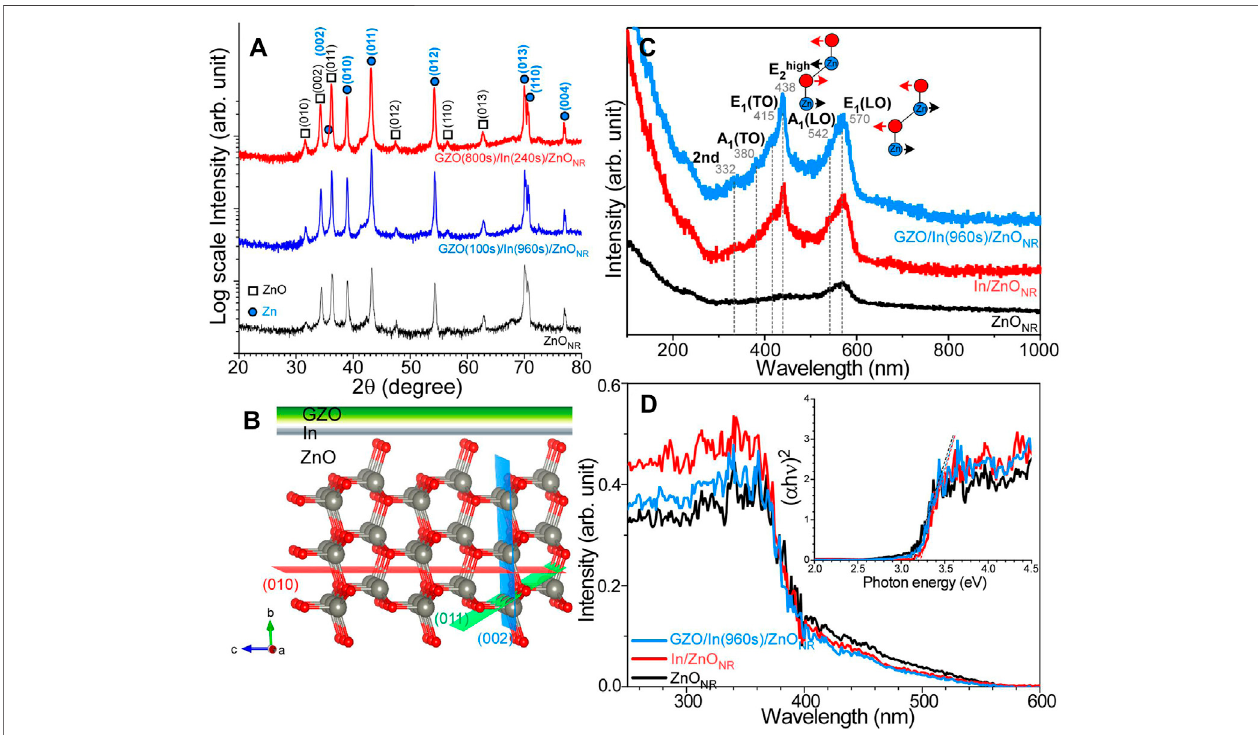
FIGURE 1 | XRD pro fi les (A) , crystal phase projections (B) , Raman spectra (C) , and UV-visible absorption spectra (D) of bare ZnO NR , In/ZnO NR , and GZO/In/ ZnO NR electrode samples. Inset fi gure in (D) shows the plots of ( α h ] ) 2 vs. hv .